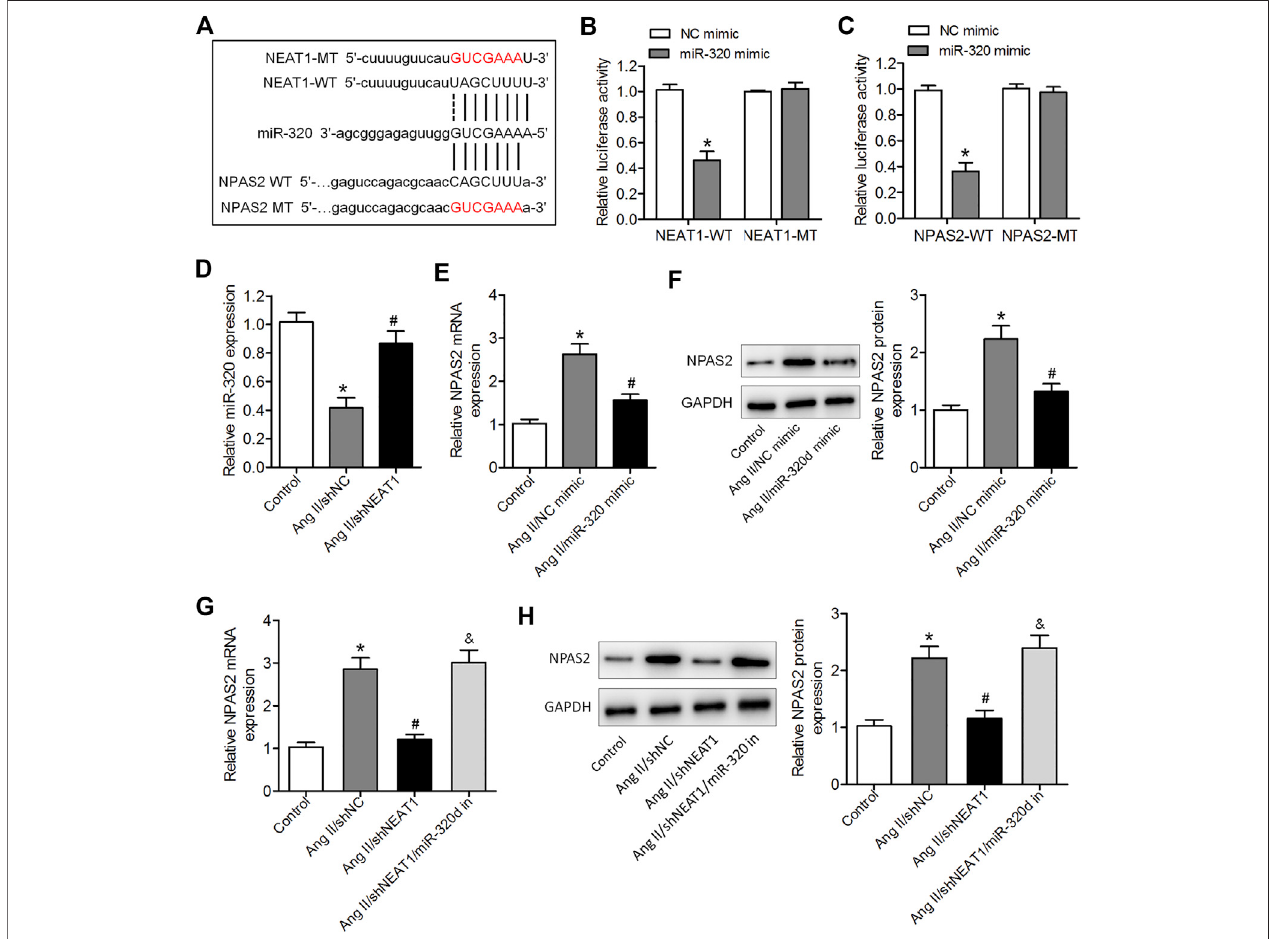
FIGURE3| NEAT1 regulatedNPAS2 expression through miR-320. (A) The predicted miR-320 and NPAS2 bindingsites in NEAT1 (NEAT1-WT) and the designed mutantsequence(NEAT1-MTandNPAS2-MT)wereindicated. (B) TheluciferasereporterassayinHEK293Tcellsco-transfectedwithNEAT1-WTorNEAT1-MTandNC mimic or miR-320 mimic. (C) The luciferase reporter assay in HEK293T cells co-transfected with NPAS2-WT or NPAS2-MT and NC mimic or miR-320 mimic. (D) miR- 320 expression in Ang II-induced cardiac fi broblasts transfected with shNC or shNEAT1. (E,F) mRNA and protein expressions ofNPAS2 inAng II-induced cardiac fi broblaststransfectedwithNCmimicormiR-320mimic. (G,H) mRNAandproteinexpressionsofNPAS2inAngII-inducedcardiac fi broblaststransfectedwithshNEAT1 or co-transfected with shNEAT1and miR-320 inhibitor were determined. * p < 0.05 vs. NC mimic group or control group; # p < 0.05 vs. Ang II/shNC group; & p < 0.05 vs. Ang II/shNEAT1/miR-320 inhibitor group. Data represent mean ± SD from three independent experiments.